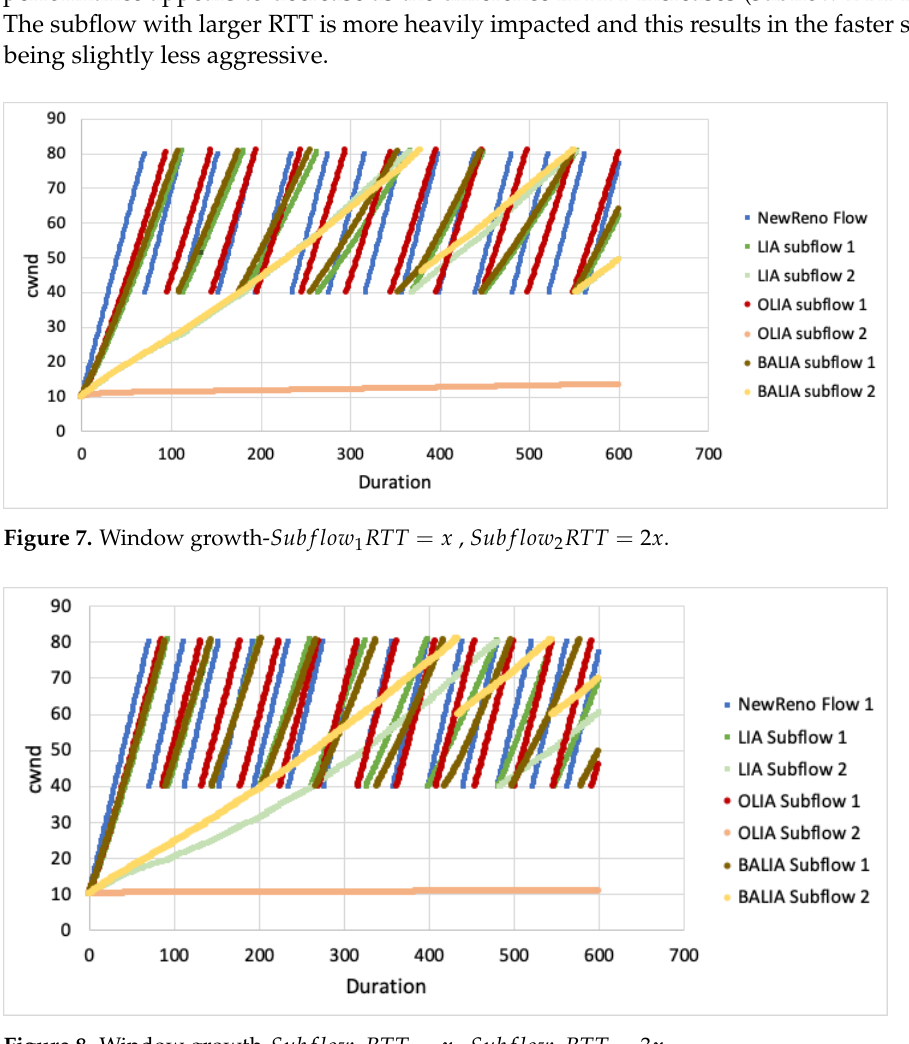
Figure 8. Window growth- Subflow 1 RTT = x , Subflow 2 RTT = 3 x